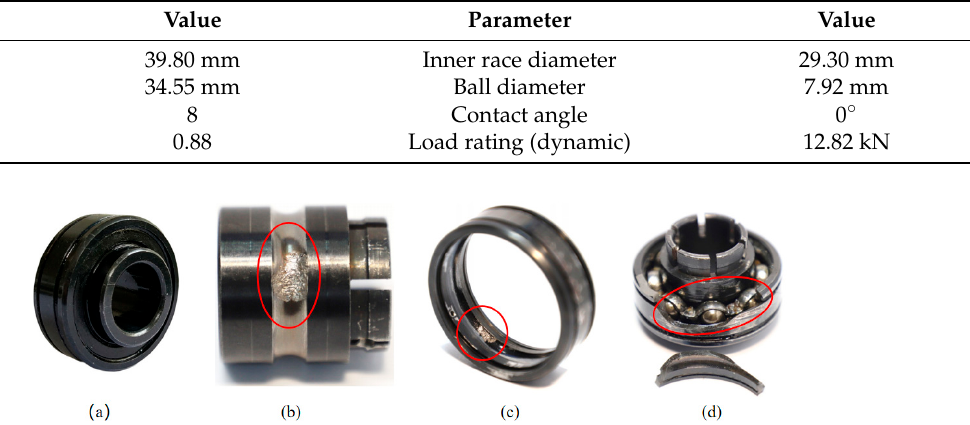
Figure 20. Photos of tested bearings: ( a ) normal bearing; ( b ) inner race wear; ( c ) outer race wear; ( d ) outer race fracture.